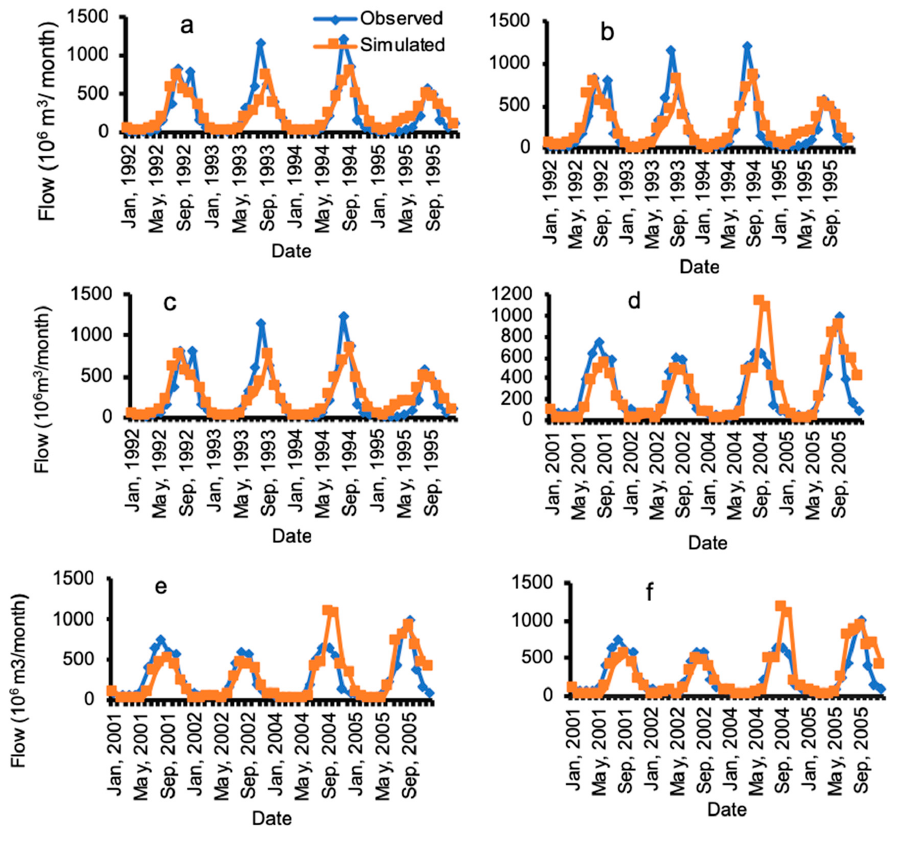
Figure 8. Observed and simulated flow under 1986 LULC ( a ), 2001 LULC ( b ) and 2015 LULC ( c ) during model calibration and 1986 LULC ( d ), 2001 LULC ( e ) and 2015 LULC ( f ) during model